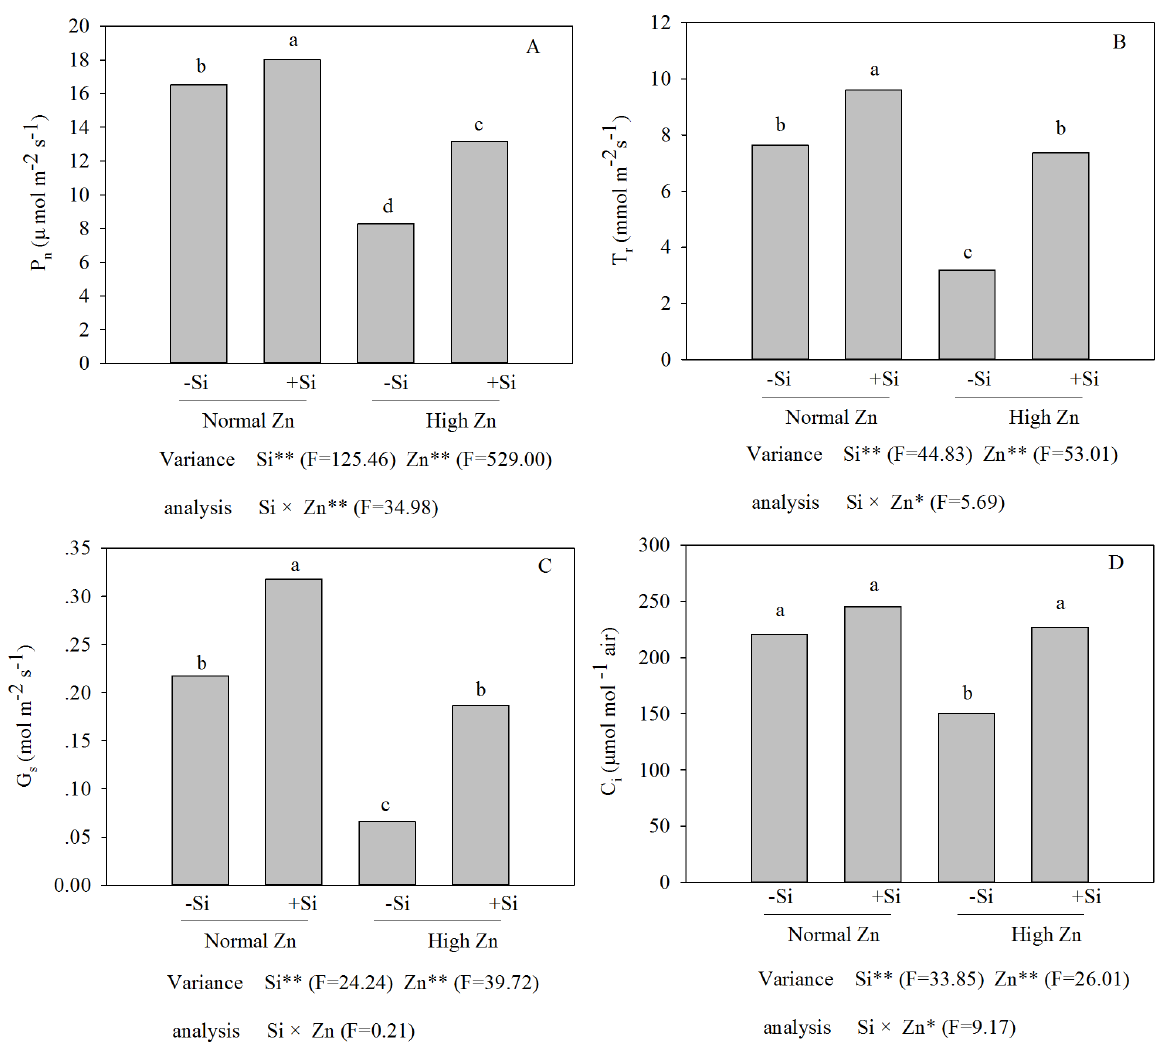
Figure 6. P n (A), T r (B), G s (C) and C i (D) of Zn-sensitive rice ( Oryza sativa L.) cultivar grown hydroponically with either normal (0.15 m M) or high (2 mM) Zn without or with 1.5 mM Si for seven days. Data are means ¡ S.D. of three replicates. Note:P-values indicate significance level based on two- way ANOVA. * P , 0.05, ** P , 0.01. Data followed by different letters are significantly different according to ANOVA (P ,